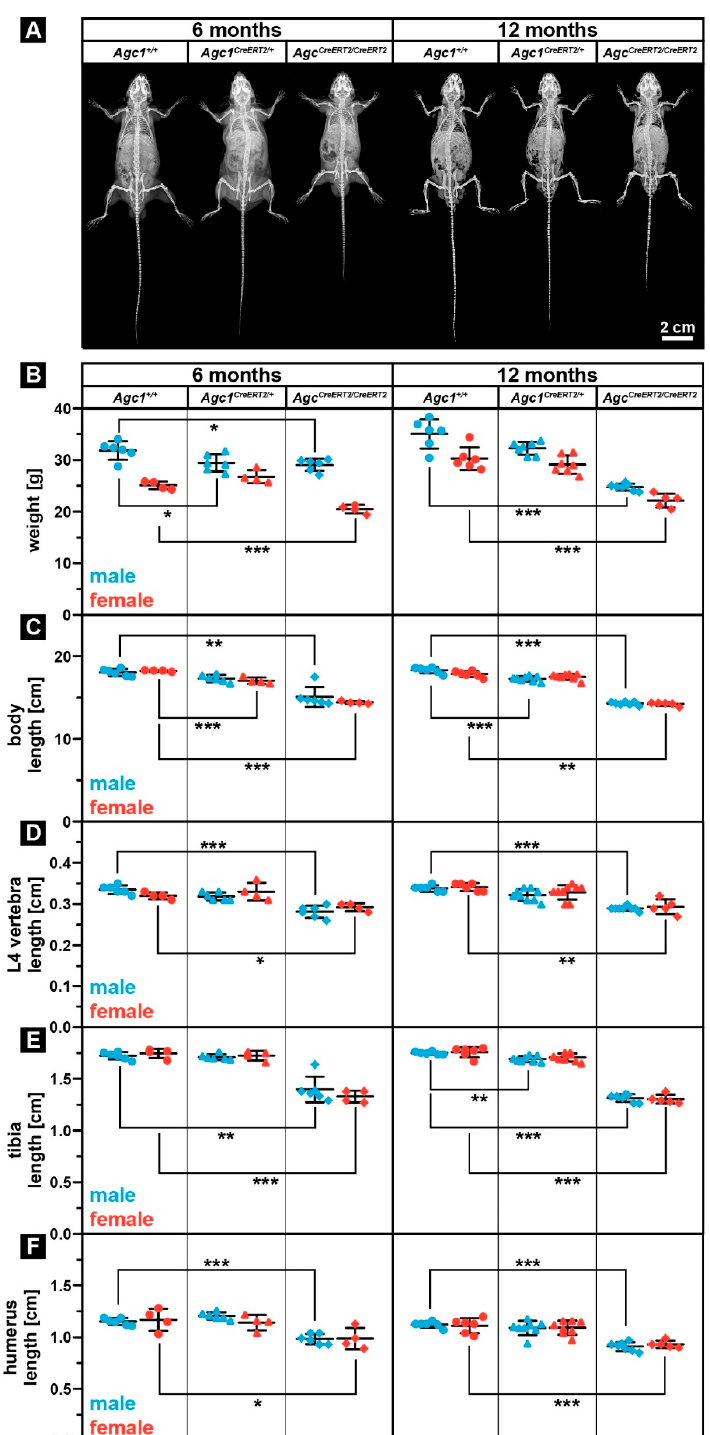
Figure 1. Agc1 CreERT2/CreERT2 mice develop dwarfism which is maintained after skeletal maturation. ( A ) representative X-ray images of Agc1 +/+ , Agc1 CreERT2/+ and Agc1 CreERT2/CreERT2 mice at 6 and 12 months of age. ( B – F ) analysis of body weight ( B ), body length ( C ), L4 vertebra length ( D ), tibia length ( E ) and humerus length ( F ) at 6 and 12 months of age. Bars represent the mean ± standard deviation (SD). n > Agc1 +/+ : 6(m)/4(f); Agc1 Cre/+ : 6(m)/4(f); Agc1 Cre/Cre : 6(m)/4(f) at six months; and n > Agc1 +/+ : 6(m)/6(f); Agc1 Cre/+ : 7(m)/7(f); Agc1 Cre/Cre : 7(m)/5(f) at 12 months. Statistical significance calculated by one-way ANOVA where * p < 0.5; ** p < 0.01; *** p <